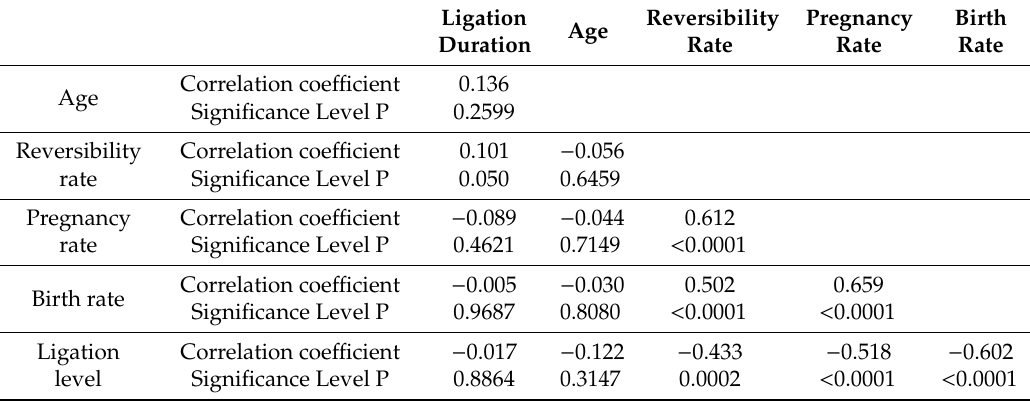
Table 3. Correlations between age group and reversibility rate, pregnancy rate, birth rate and ligation level for the patients aged under